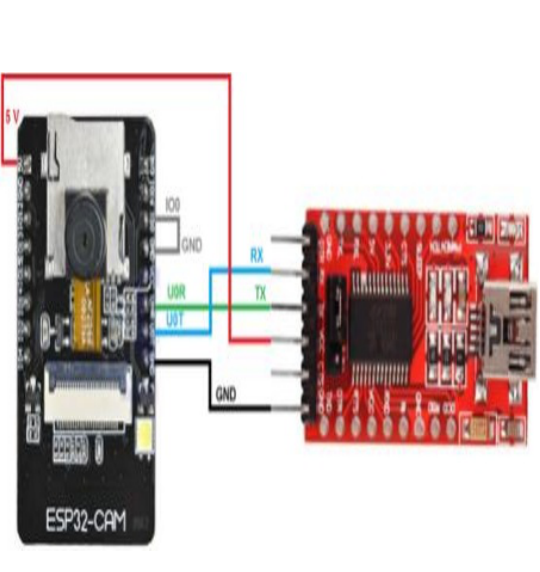
Fig.2. esp32 WiFi cam module with UART serial adap t